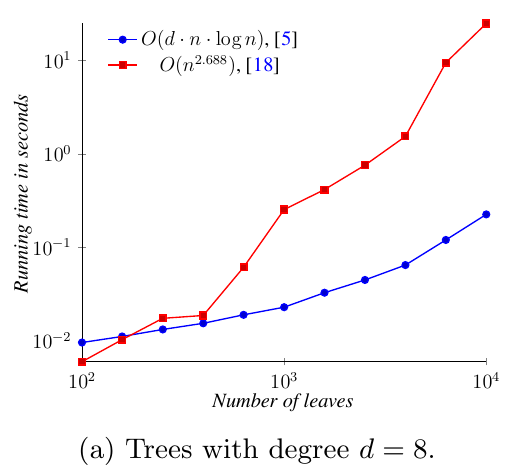
Figure 15. Quartet distance running time on non-binary balanced